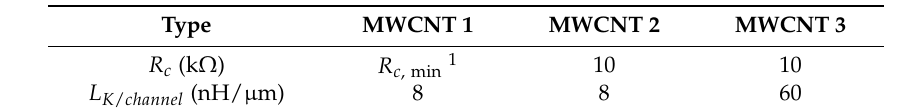
Table 2. Parameters of MWCNT